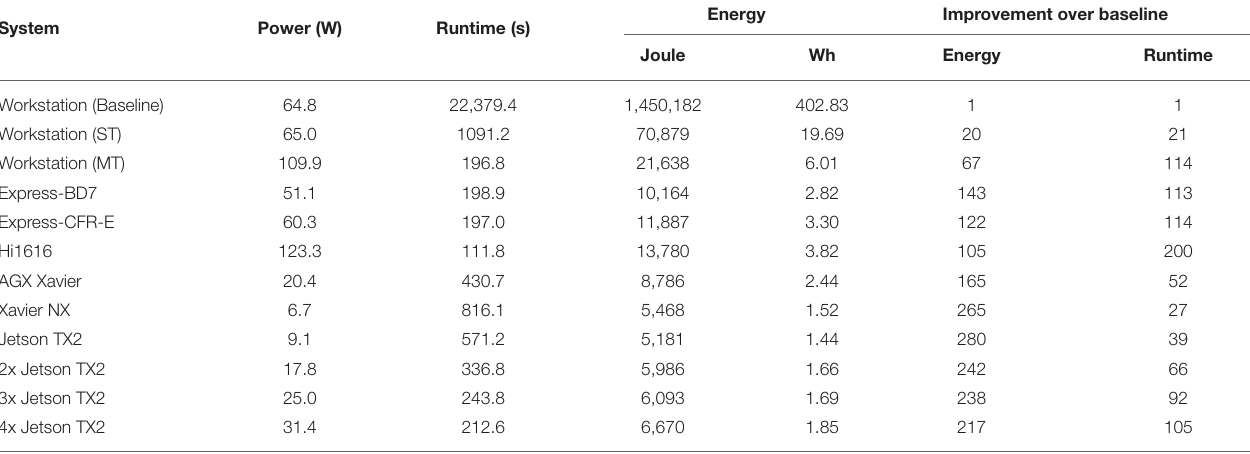
TABLE 7 | Runtime and energy consumption of all